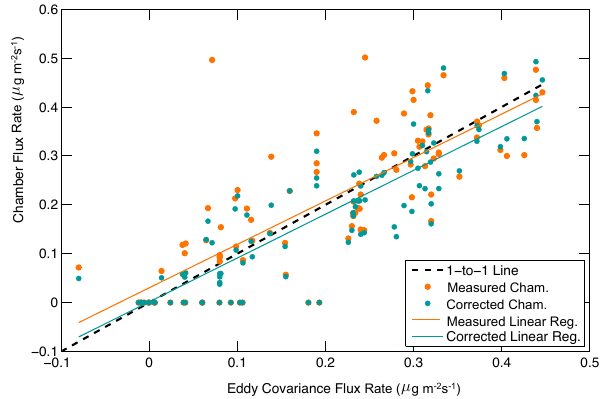
Figure 7. The plot above is a comparison of ozone fluxes measured using flux chambers with fluxes obtained via eddy covariance. The orange dots represent fluxes measured by the chambers, and the blue dots represent chamber fluxes that have been corrected using the adjusted resistance analogy. The dashed line is a 1-to-1 line. The orange line represents a linear regression of the measured cham- ber fluxes, and the blue line is a linear regression of the corrected chamber